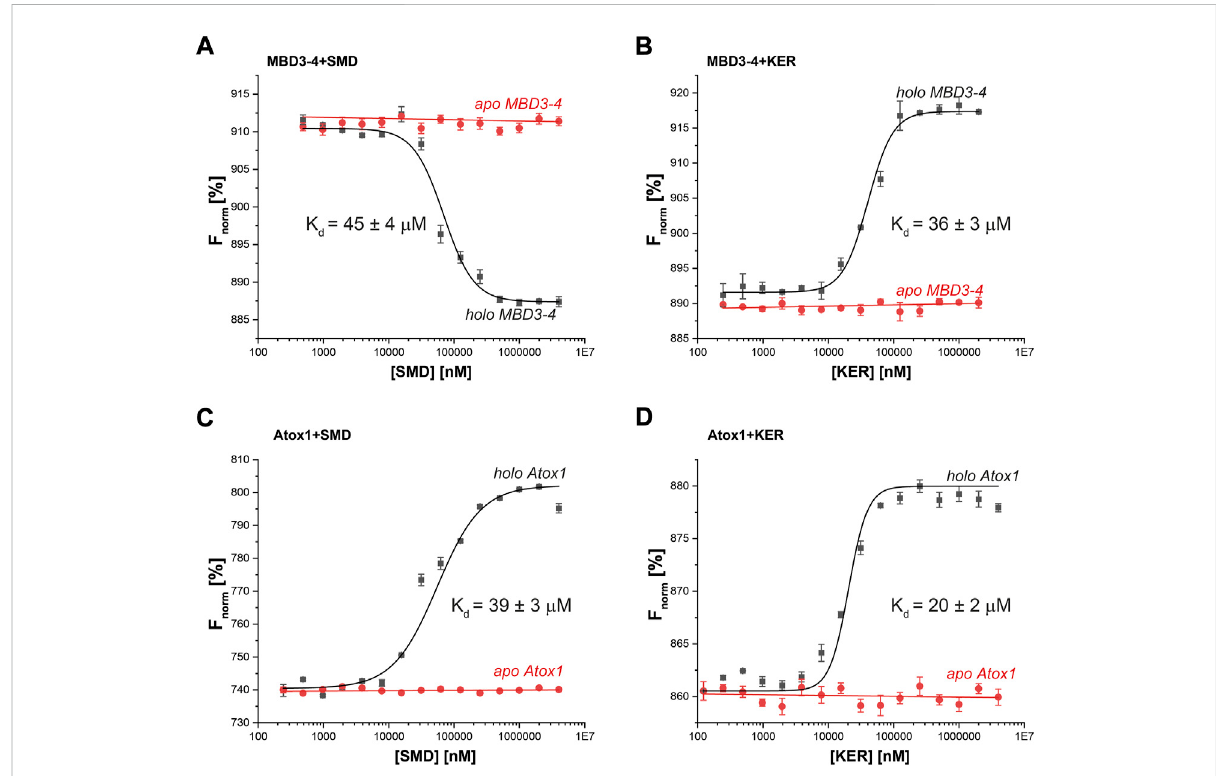
FIGURE 3 Thermophoresisanalysisof protein-peptide interactions inthe presence (black curves) or absence(red curves) of Cu(I) (40 µM) for (A) MBD3-4 protein and SMD peptide; (B) MBD3-4 protein and KER peptide; (C) Atox1 protein and SMD peptide; (D) Atox1 protein and KER peptide. The binding isotherms were generated by plotting normalized fl uorescence against the concentration of a non- fl uorescent binding partner (peptide). The protein concentration was 50 nM. Error bars were calculated based on three independent